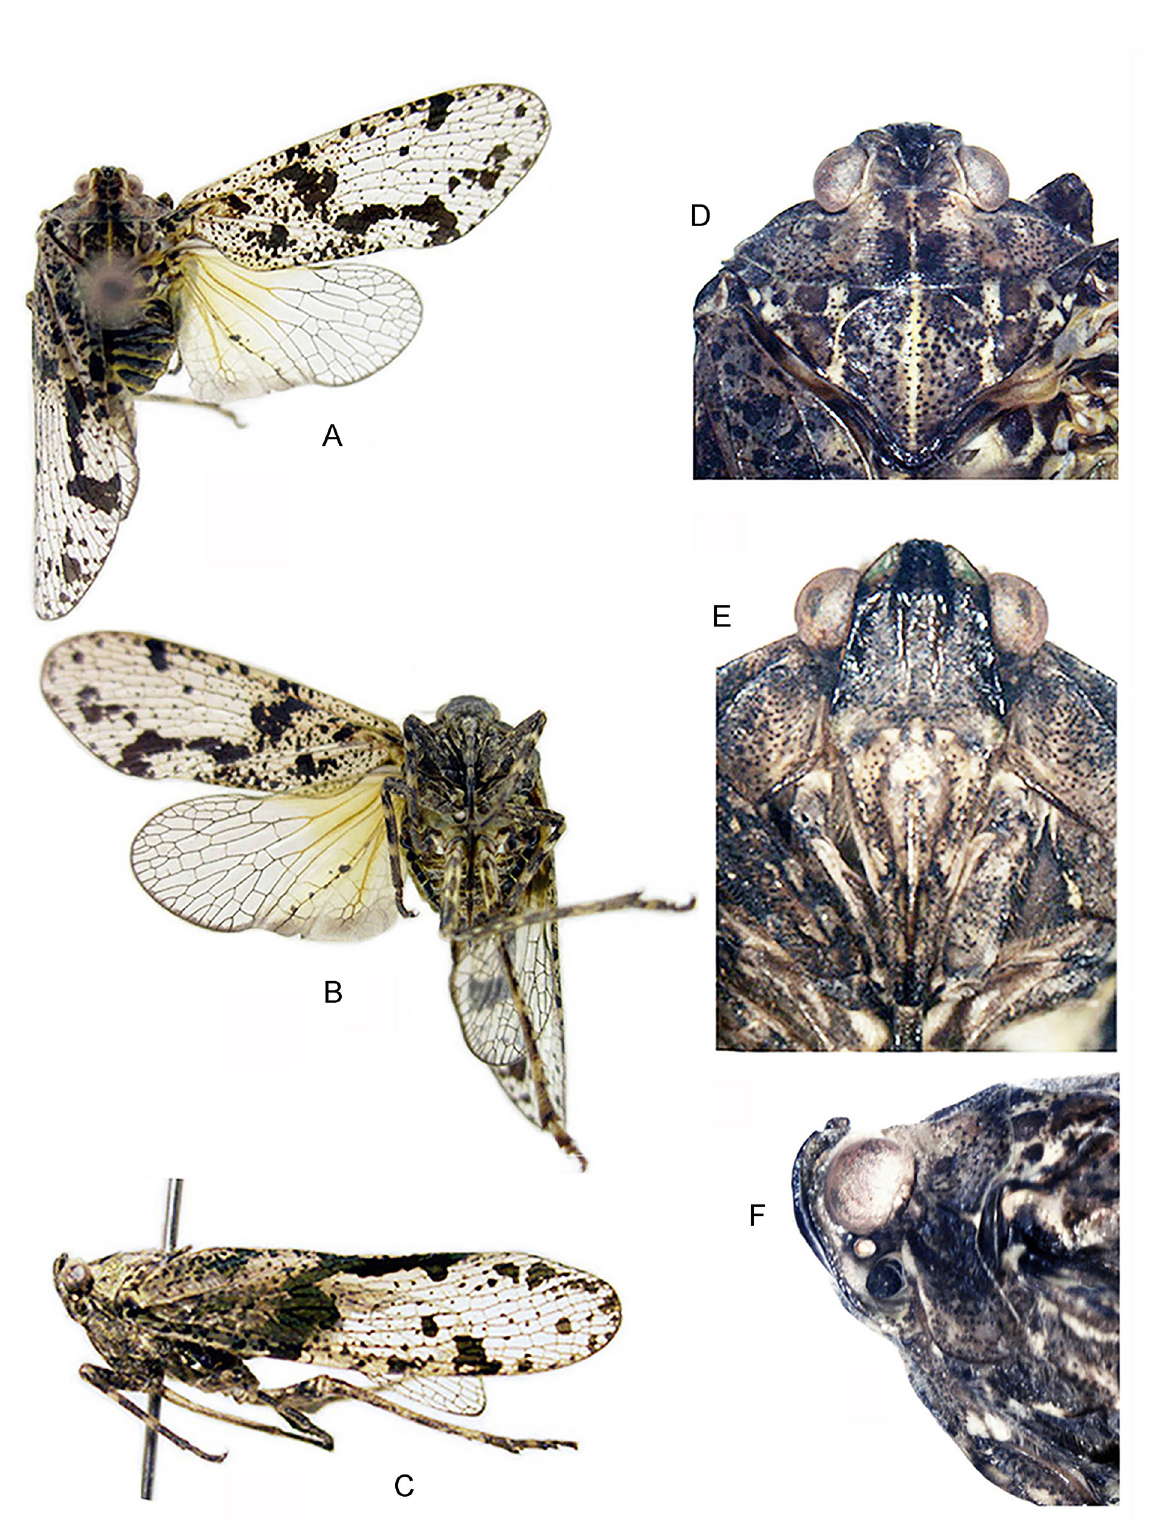
Fig. 6. Limois sordida sp. nov., Shanxi, Ningwu, Mt. Luyashan, Ai-ping Dong leg., NWAFU, adult male. A . Dorsal view. B . Ventral view. C . Left lateral view. D . Head and thorax, dorsal view. E . Face. F . Head and thorax, left lateral view (showing reflexed protuberance of the